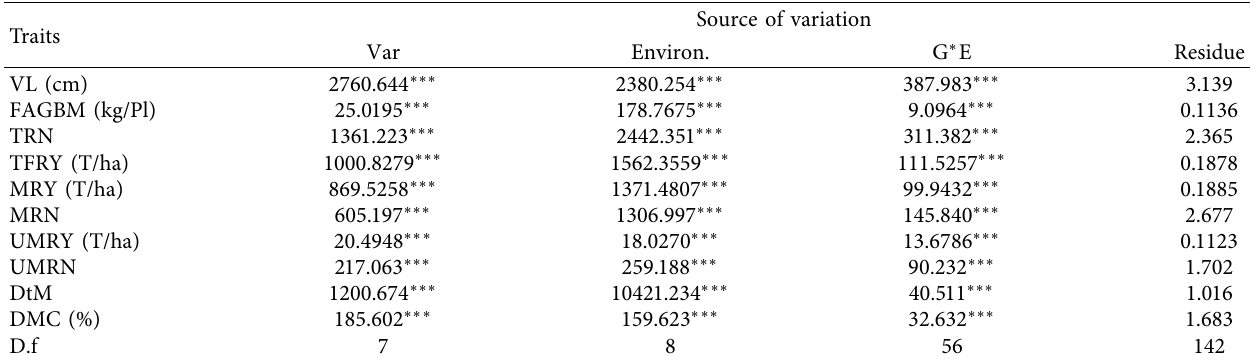
Source of variation